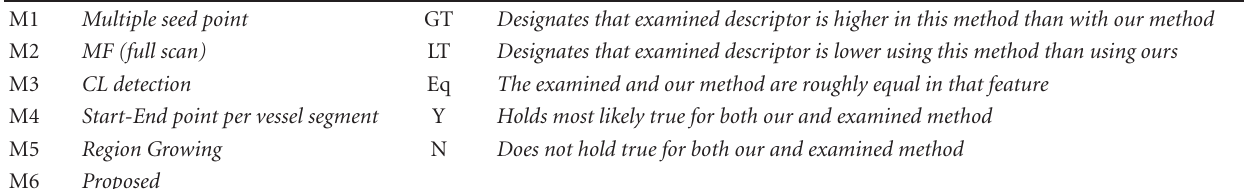
Figure 7: Process/Data Flow Chart depicting the basic information flow in our method. Table 3: Designations for methods or sub-modules used in Table